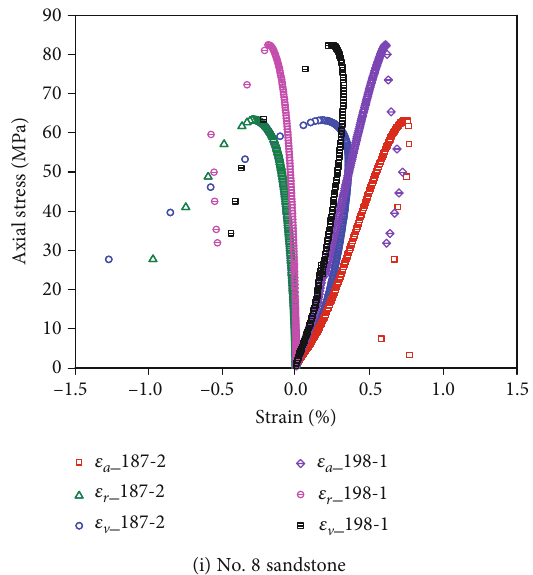
Figure 4: Complete stress-strain curves of all the specimens.